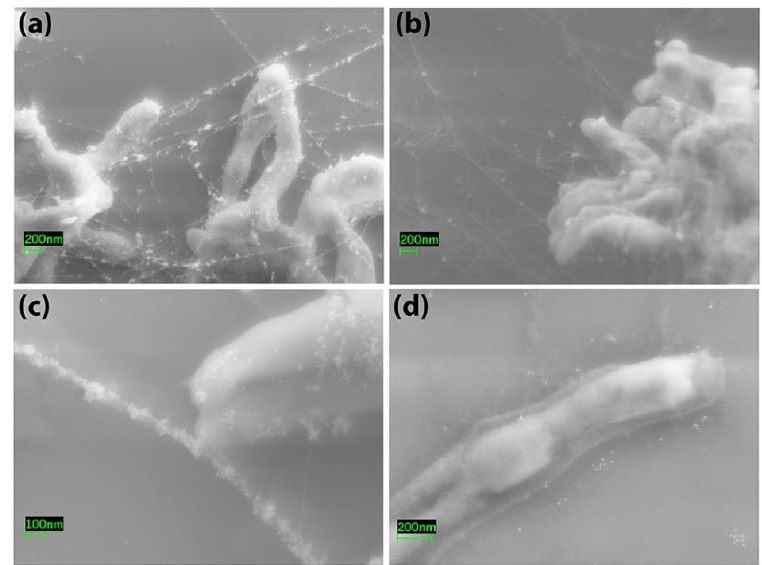
Figure 3. Scanning electron microscopy of Map pre and post EtOH extraction. Map were exposed to bovine serum from a JD-positive ( a , c , and d ) and a JD-negative cow ( b ). The images in ( a ), ( b ) and ( c ) were taken prior to EtOH extraction while ( d ) was taken after EtOH extraction. Note the clear zone at the surface indicating the stripped nature of the cell wall in ( d ). Magnification is indicated by size bars in the lower left corner of each image.